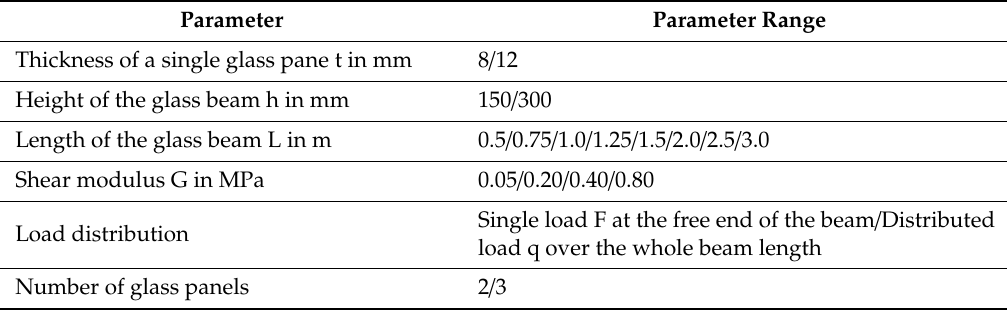
Table 7. Used parameters and parameter